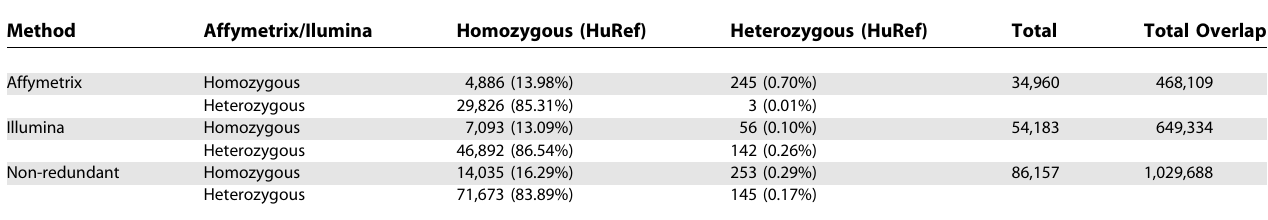
Table 9. Discordant Calls in SNP Genotyping Validation Using Affymetrix 500K, Illumina HumanHap650Y in Comparison with Sequence from the HuRef